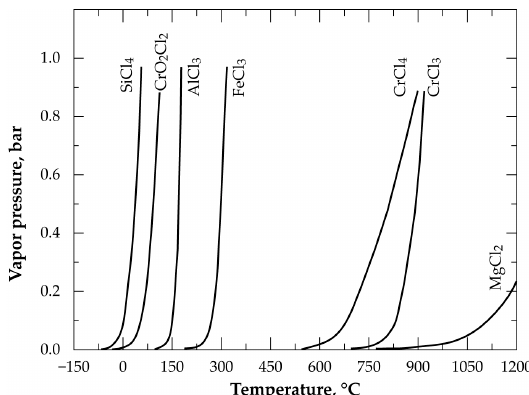
Figure 5. Vapor pressure versus temperature for several chlorides likely to be produced during chromite chlorination.